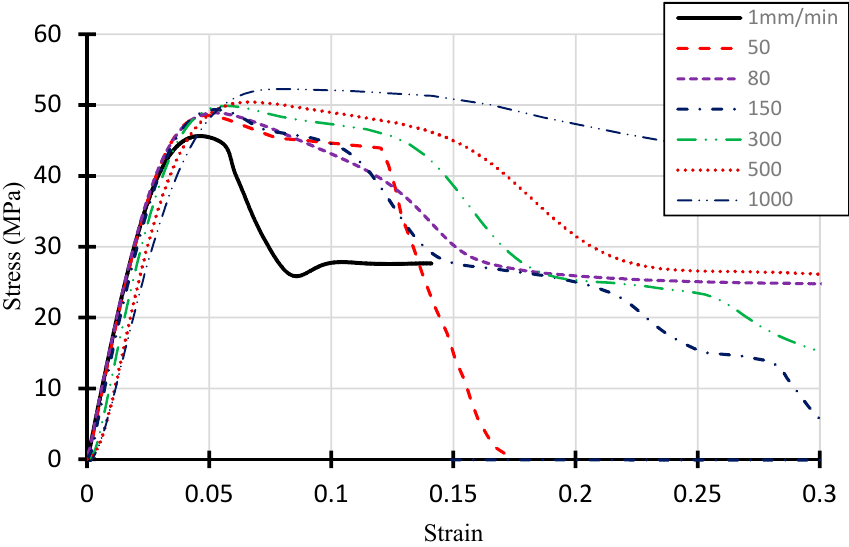
Figure 6. Tensile stress-strain curves obtained at a range of 1–1000 mm/min.